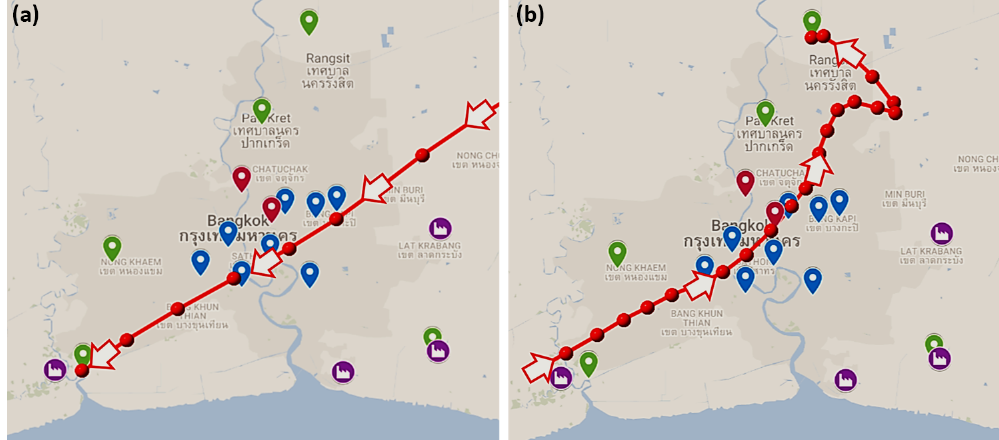
Figure 7. Backward trajectories from the HYSPLIT model reveal a (a) NE wind direction (13 January 2010) and (b) SW wind direction (1 January 2010). Table 2. The comparison of CO / NO x and SO 2 / NO x ratios from this study with other studies (modified from Rasheed et al., 2014). Region Source CO / NO x SO 2 / NO x This